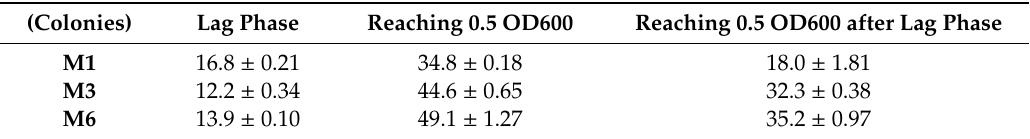
Table 3. The duration for growth phases of L. pentosus from breast milk determined by regression model